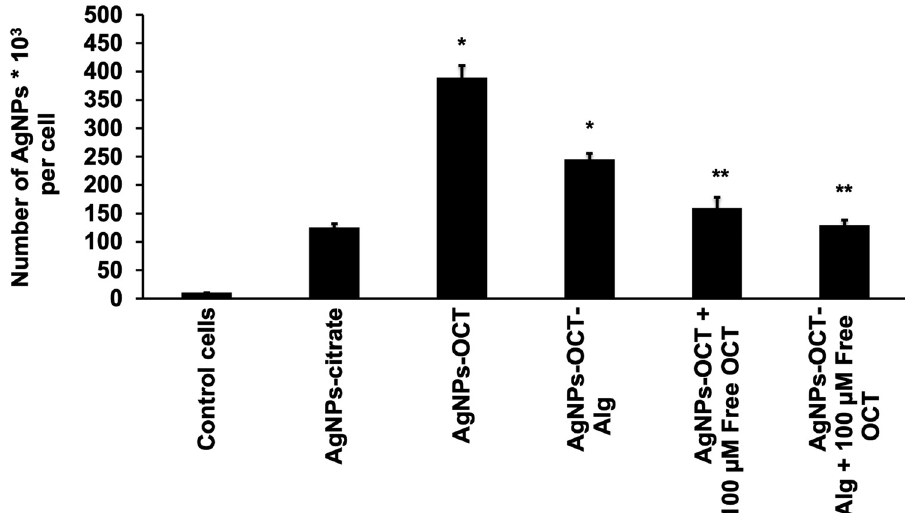
Figure 6: Cellular uptake of the AgNPs – CTT, AgNPs – OCT, and AgNPs – OCT – Alg was determined by ICP - OES and cell counting after 60 min